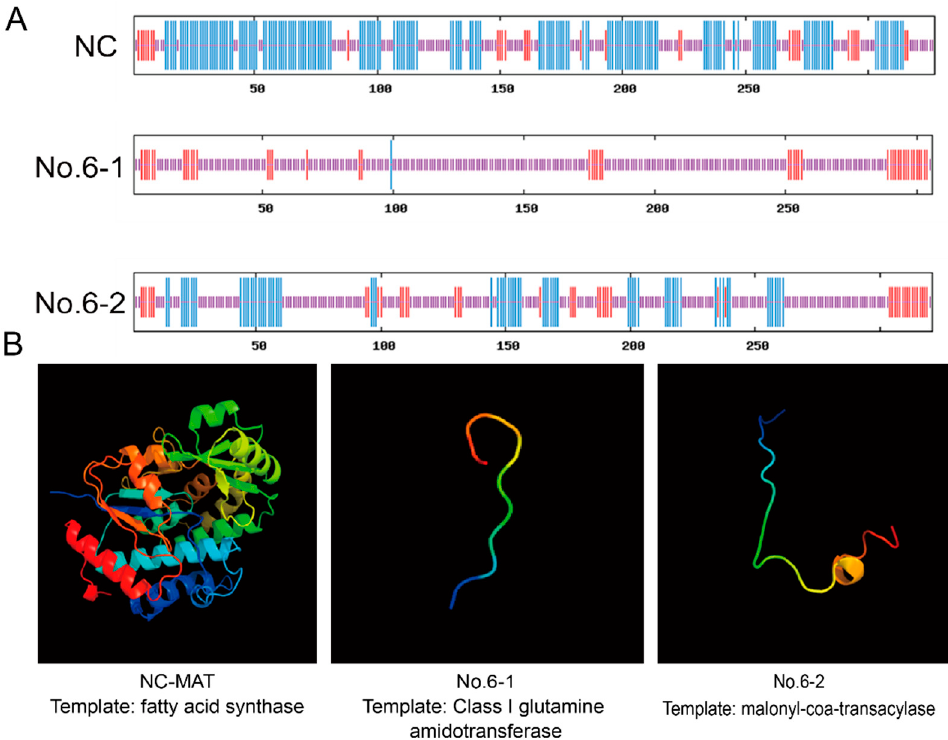
Figure 2. The bioinformatics analysis of MAT knockout efficiency. ( A ) Secondary structure analysis. NC—negative control cells; NO.6-1—a genotype of NO.6; NO.6-2—another genotype of NO.6; long vertical line— α -helix; middle vertical line— β -fold; Short vertical bar—irregular curl. ( B ) Tertiary structure analysis. From N to C, it is red, orange, yellow, green, cyan, blue, and purple, respectively.